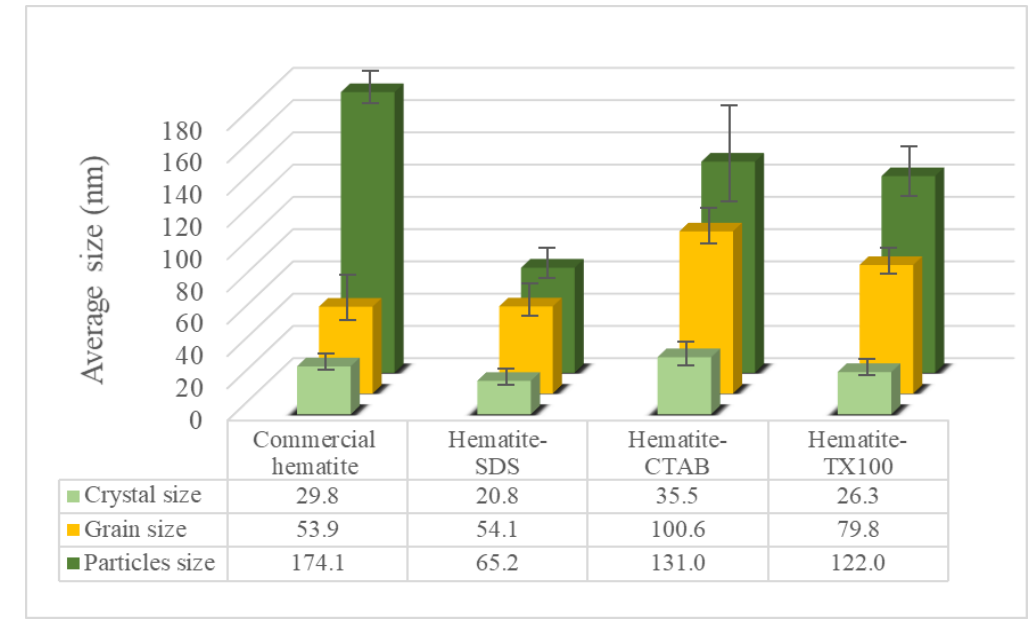
Figure 4. Crystal size obtained by XRD, grain size from ImageJ analysis of TEM images and particle size from ImageJ analysis of FE-SEM images of α-Fe 2 O 3 nanoparticles.